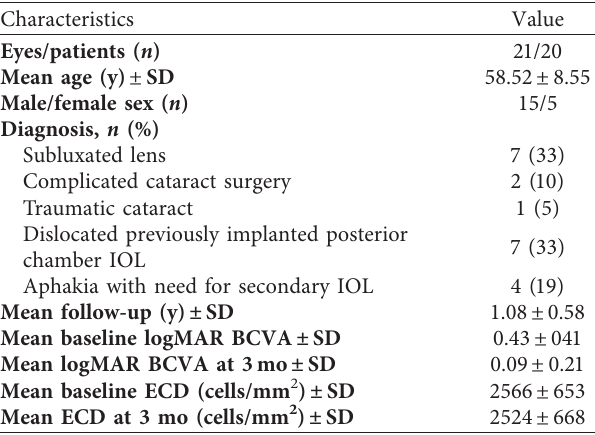
Figure 3: Postoperative 3-month follow-up anterior segment photograph of a 55-year-old woman who underwent the trans- scleral-sutured IOL implantation due to complicated cataract surgery. Table 1: Baseline characteristics and postoperative